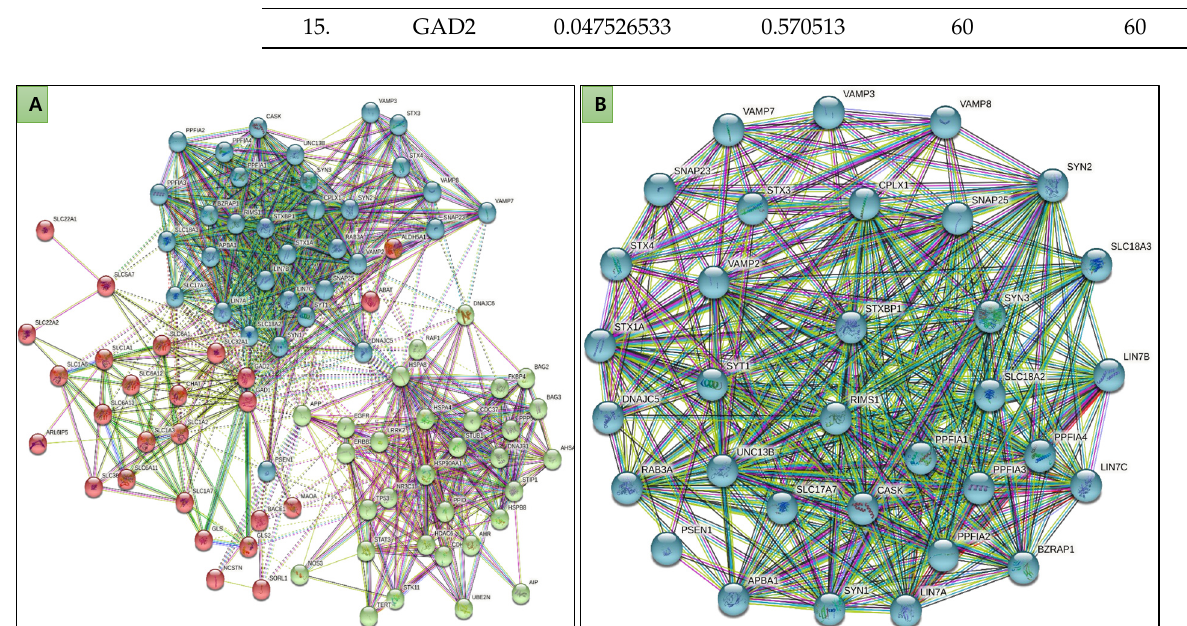
Figure 1. Protein-Protein interaction network of 51 selected genes. ( A ) Top 3 clusters of the interaction, ( B ) showing the largest cluster where STXBP1 interacts with other genes.